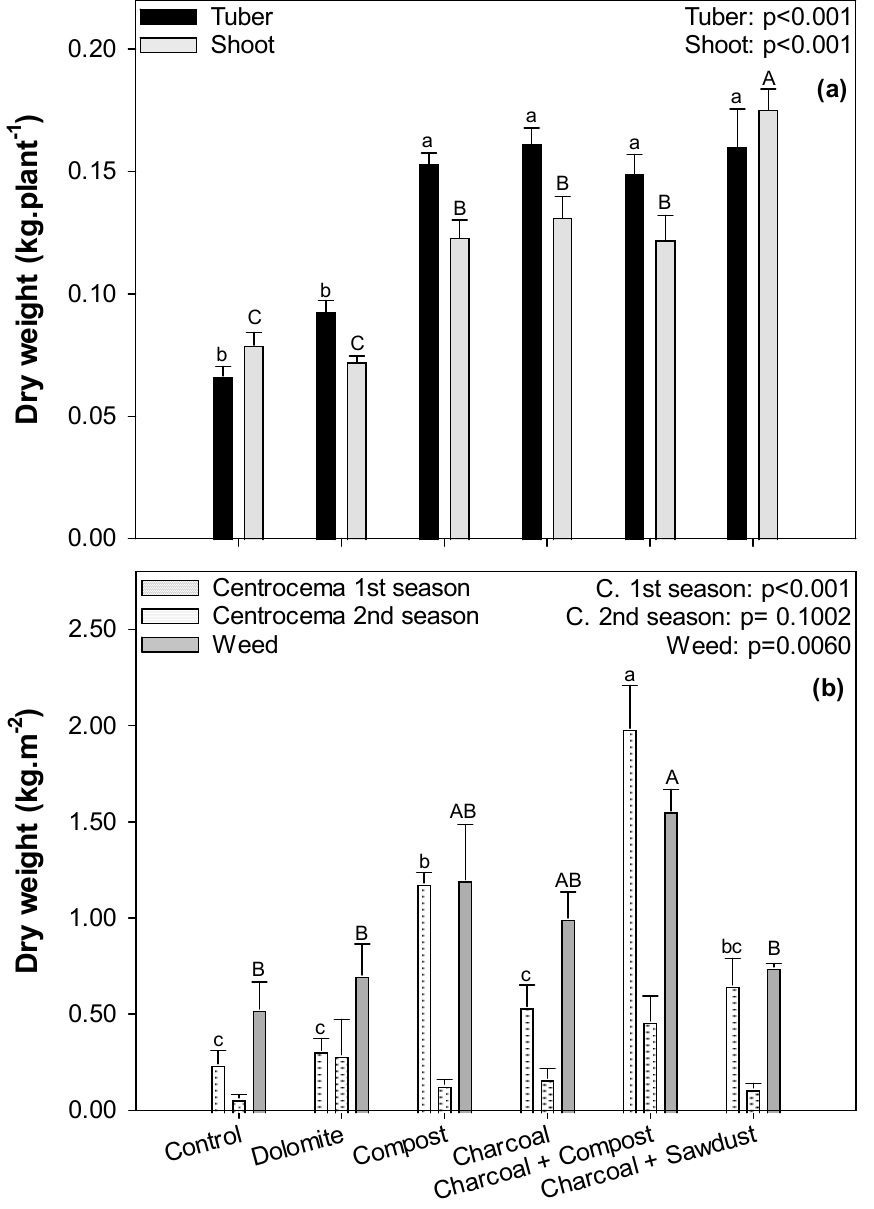
Figure 2. Yield of cassava tuber and shoot ( a ) and yield of centrosema 1st season, centrosema 2nd season, as well as weed ( b ) in different soil amendment treatments. Given are mean ± SE ( n = 4). Different uppercase letters and lowercase letters indicate significant differences in cassava’ s tuber, centrosema 1st season, cassava’s shoot and weed, respectively as revealed by one-way ANOVA followed by post hoc test at p < 0.05.